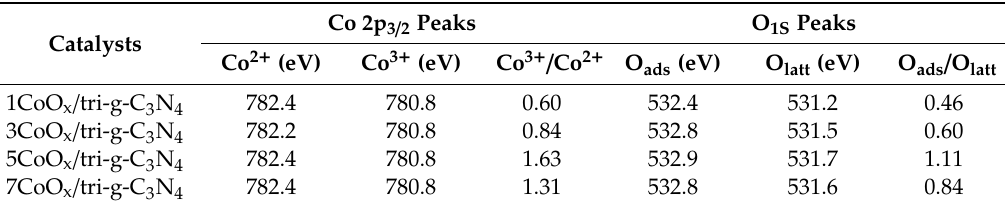
Table 2. XPS results of CoO x / tri-g-C 3 N 4